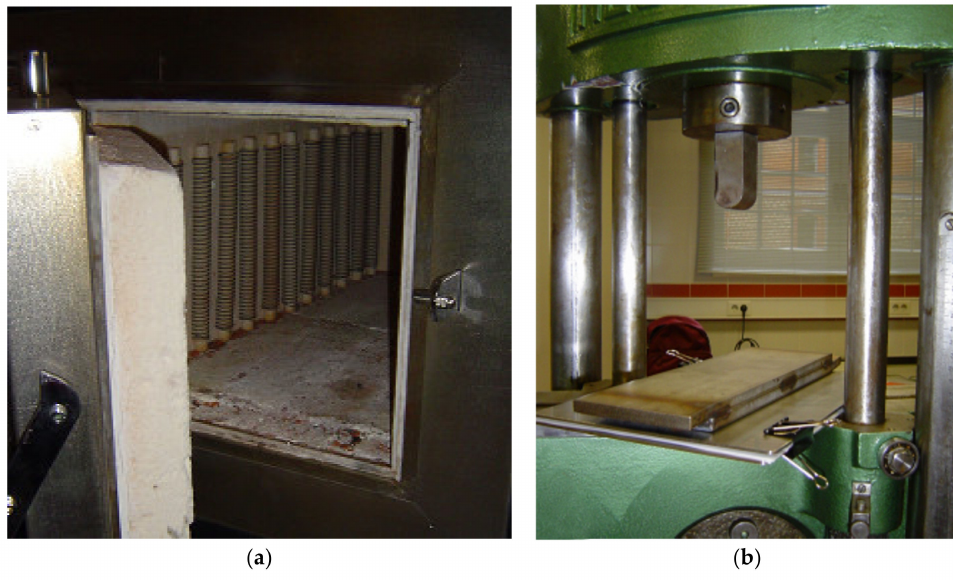
Figure 3. ( a ) Furnace and ( b ) pressing machine 10 Tn. Max.